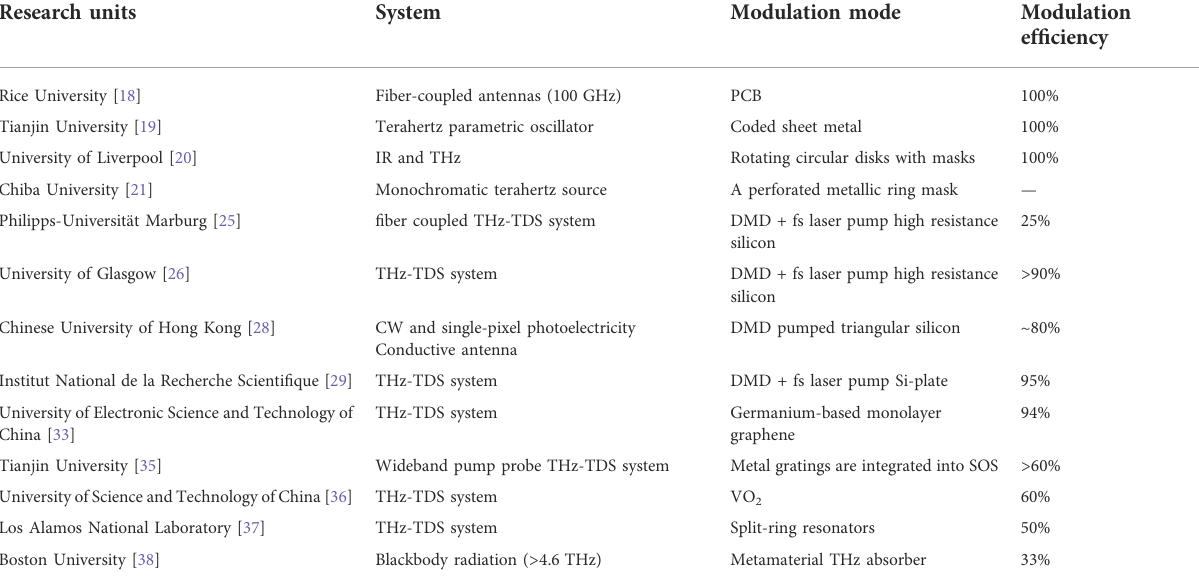
TABLE 1 Comparison of modulation methods in THz single-pixel